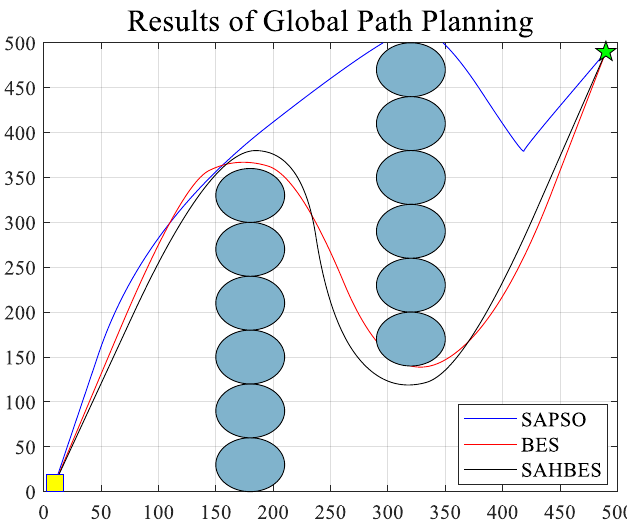
Figure 11. Global path planning chart of trap obstacles simulation II.